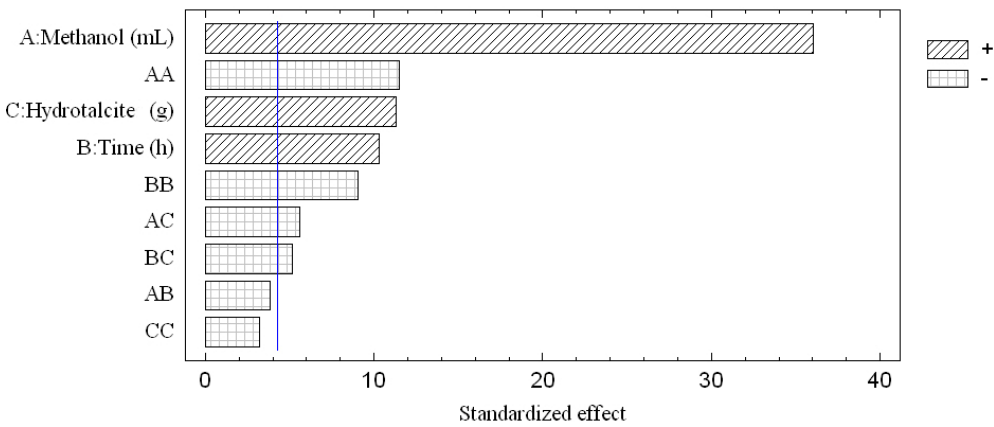
Figure 2. Pareto chart of the standardized effect of fatty acid methyl ester (FAME) conversion ( α = 0.005).